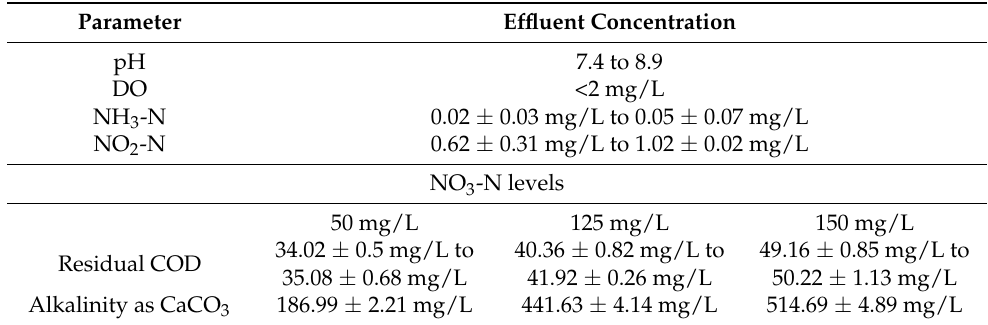
Table 3. The quality of various effluent parameters of the